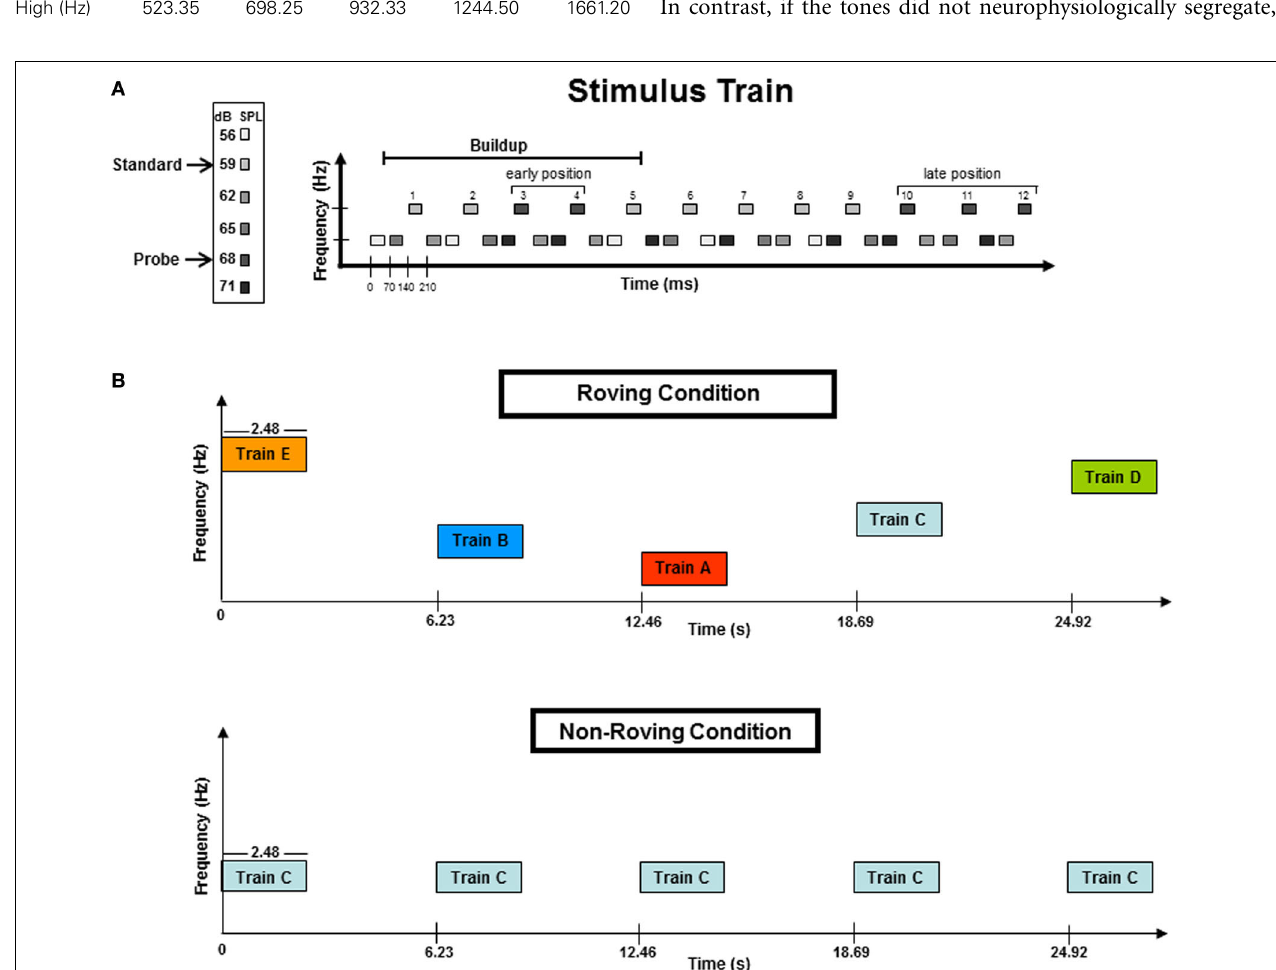
FIGURE 1 | (A) A stimulus train consisted of 36 tones: 24 lower (L) frequency tones and 12 higher (H) frequency tones presented in a three-tone repeating sequence of L-L-H. The frequency separation between the H and L tones was eight semitones (ST). The H tones formed a simple intensity oddball with early position probe tones randomized across 3rd or 4th tones in the train. The buildup period, designated by previous studies, is delineated with a horizontal line. Late position probe tones were randomized in the 10th, 11th, or 12th tones of the trains. The late position tones occurred outside (after) the buildup interval. Frequency (Hz) is represented on the vertical axis while the horizontal axis represents time (ms). (B) Schematic of the Roving and